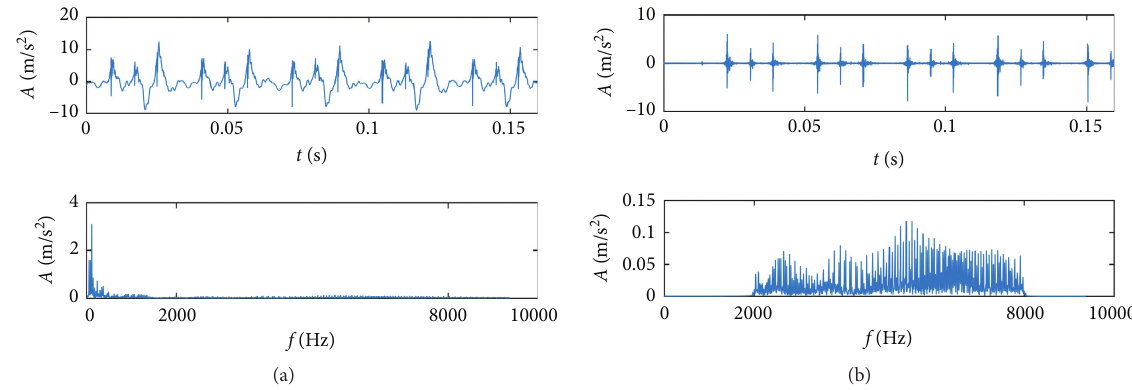
Figure 9: Vibration signal of the time domain and frequency domain under the misfire state. (a) Original signal. (b) Filtered signal.